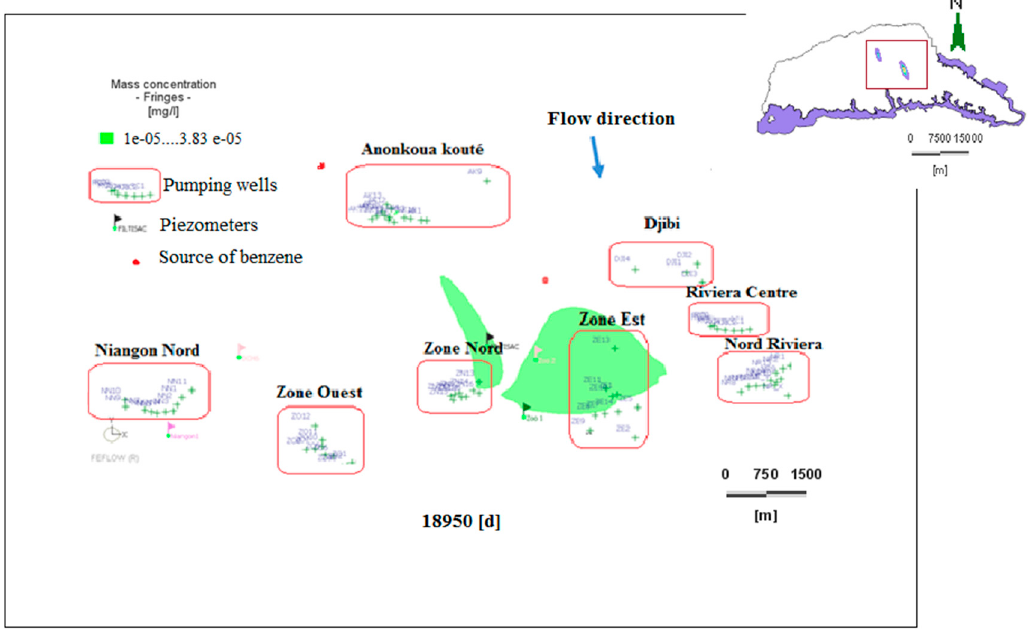
Figure 16. Dissolved benzene plume dispersion at 18,980 days (2030).